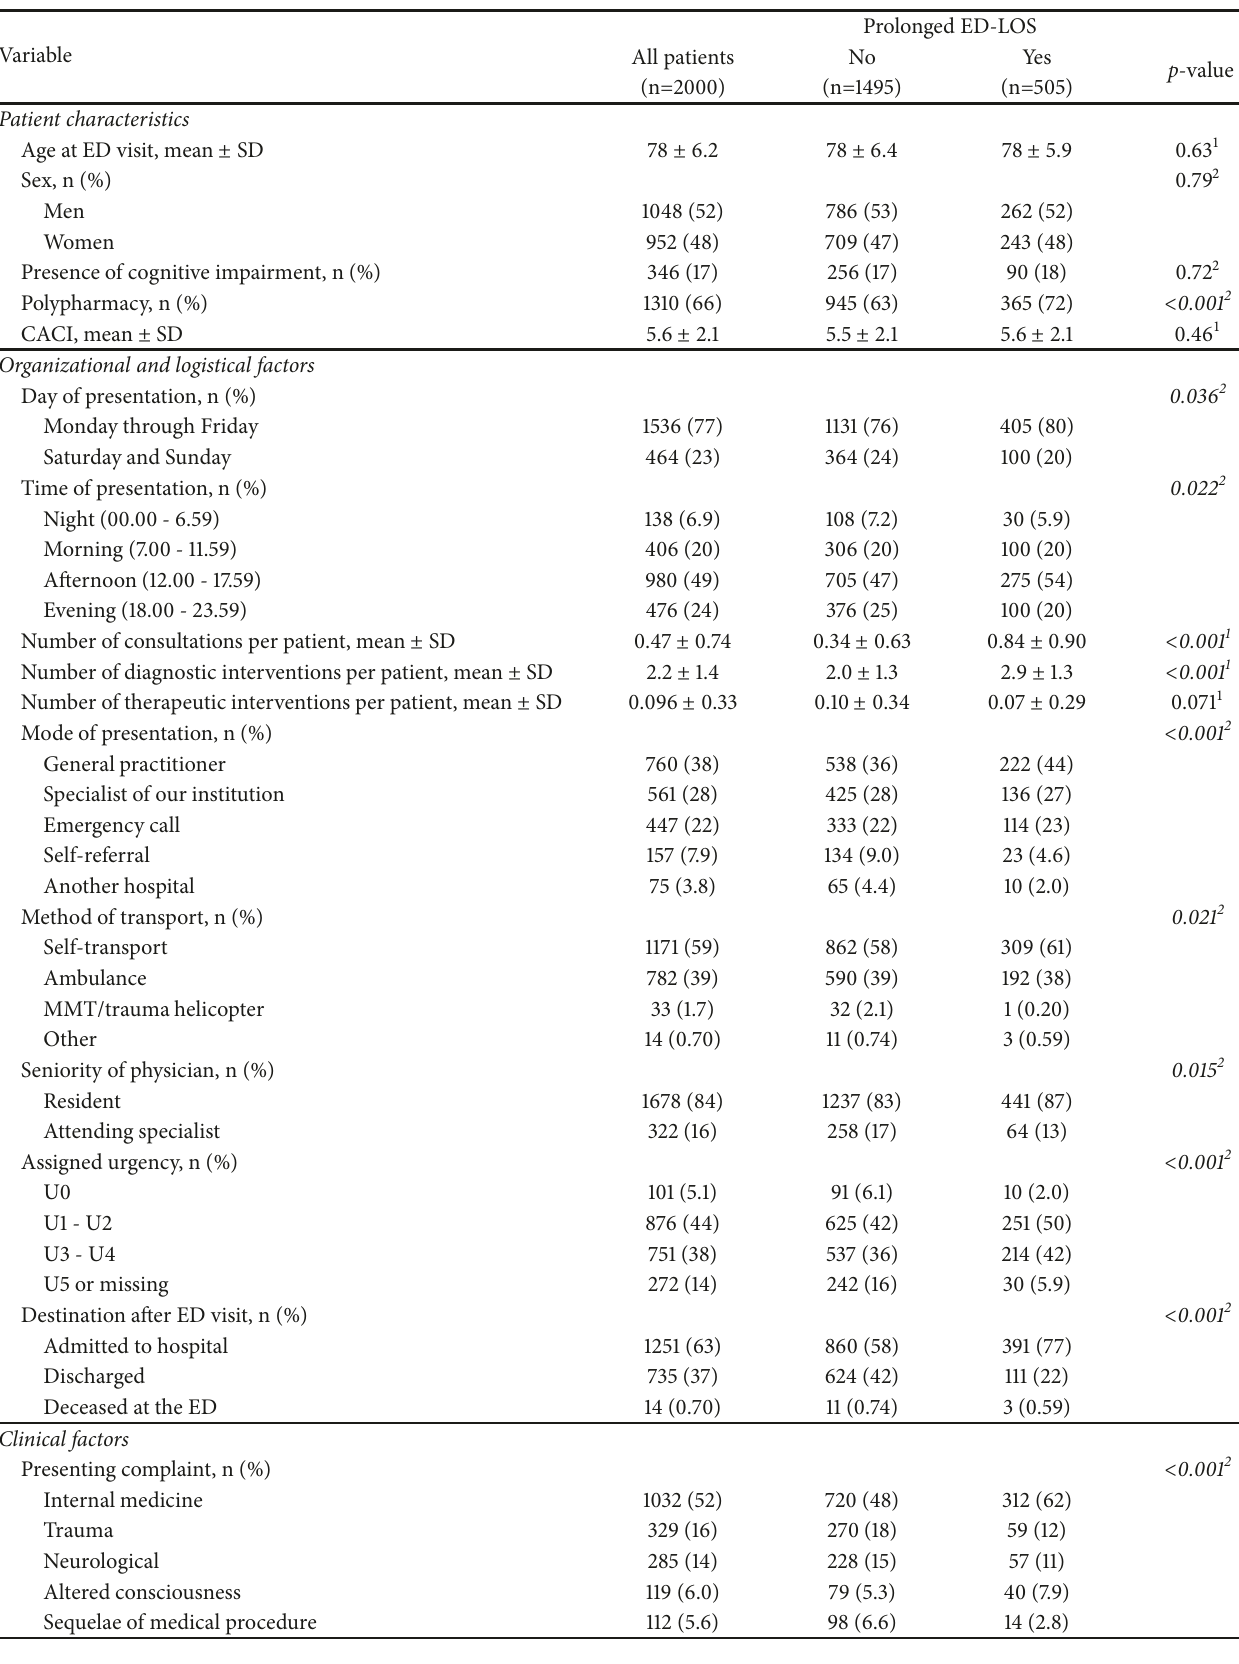
Table 4: Bivariate analysis: factors associated with a prolonged LOS at the ED (LOS > 293